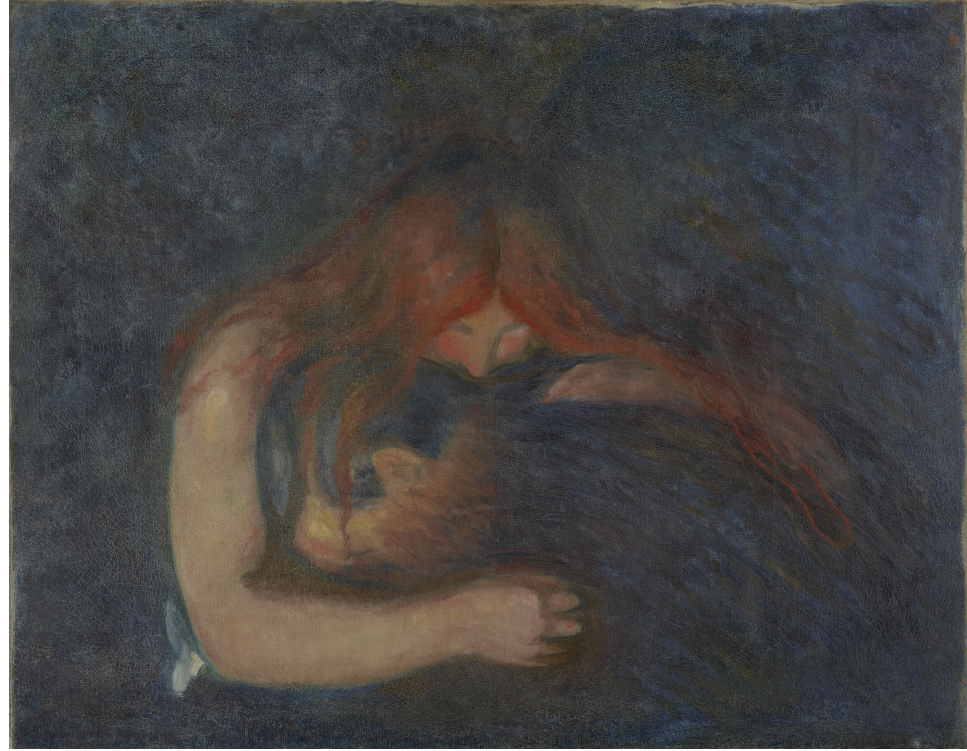
Figure 6: Vampire (1893) ©